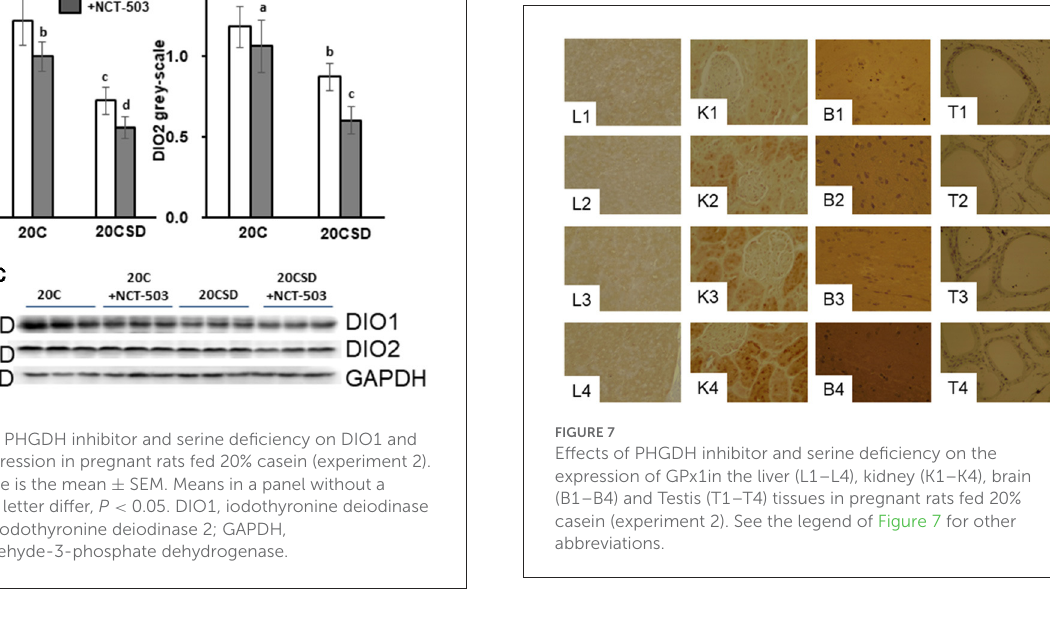
TABLE 5 Effects of PHGDH inhibitor and serine deficiency on GPx1 gray scale at organs in pregnant rats fed a 20% casein diets (experiment 2).